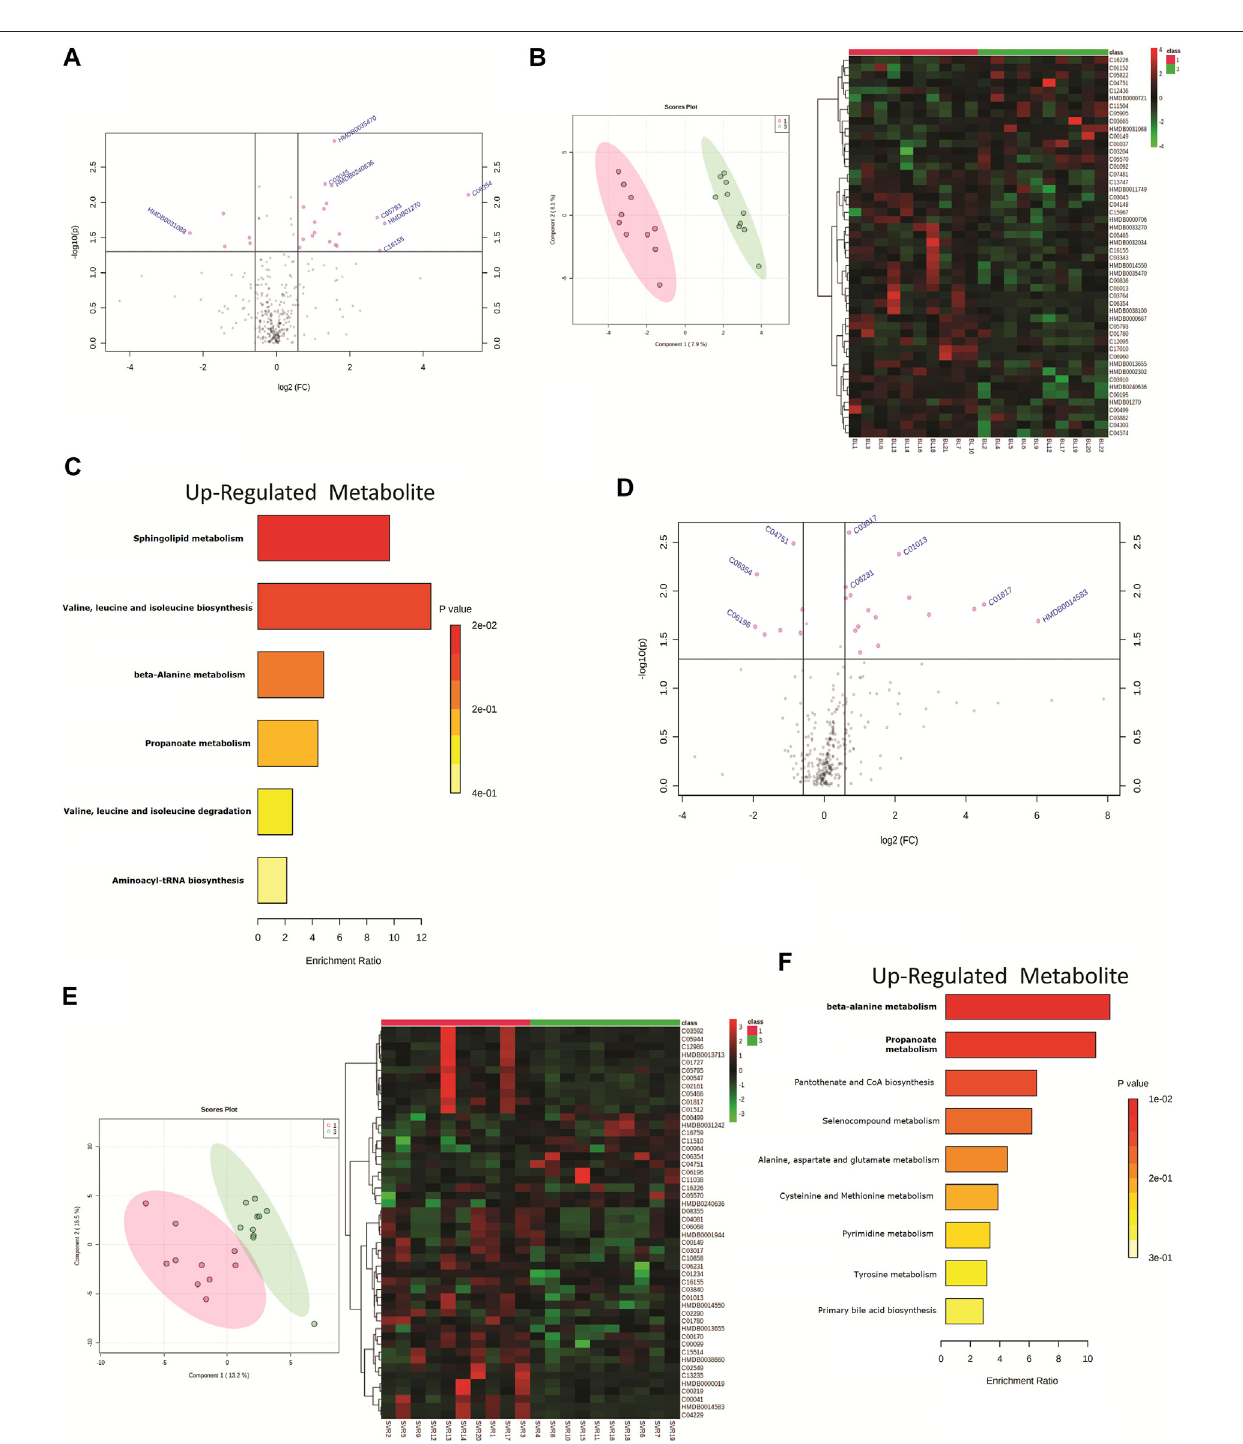
FIGURE 3 | (A) Volcano plot showing differentially expressed metabolites in patients infected with genotype 1 HCV compared to genotype 3 HCV. Pink dots are signi fi cant at baseline ( p < 0.05). Pink dotes corresponds to non-responders and green dots corresponds to responders. (B) Partial least square discriminant analysis (PLSDA)andHeatmapandhierarchicalclustershowingclearsegregationofpatientsinfectedwithgenotype1HCVcompared togenotype3HCV,atbaselinebasedon the metabolome pro fi le of patients. (C) KEGG pathway analysis of up regulated metabolites in patients infected with genotype 1 HCV compared to genotype 3 patientsat baseline. (D) Volcano plot showing differentiallyexpressed metabolites inpatientsinfected with genotype 1 HCV compared to genotype 3HCV post therapy. Pink dots are signi fi cant at ( p < 0.05). (E) Partial least square discriminant analysis (PLSDA) and Heat map and hierarchical cluster showing clear segregation of patients infected with genotype 1 HCV compared to genotype 3 HCV, Post therapy based on the metabolome pro fi le of patients. (F) KEGG pathway analysis of up regulated metabolites in patients infected with genotype 1 HCV compared to genotype 3 patients post therapy.